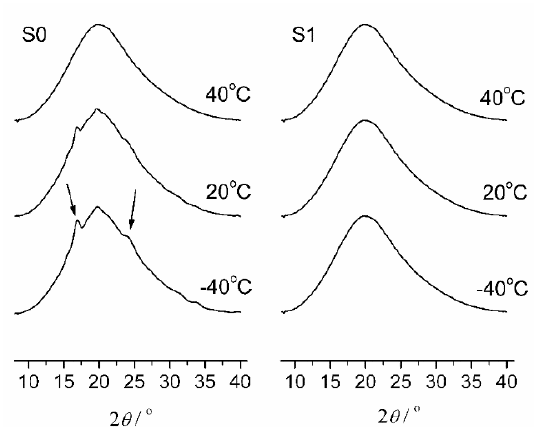
Figure 4. Wide-angle X-ray diffraction (WAXD) curves of elastomer S0 and S1 at different temperatures.